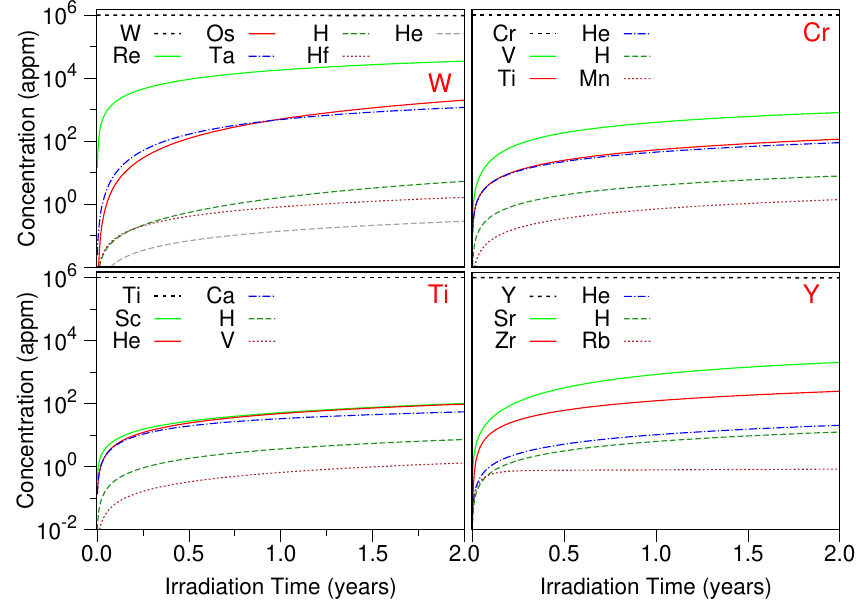
Figure 1. Transmutation (burn-up) response of W, Ti, Cr, and Y under a typical fusion first wall irradiation